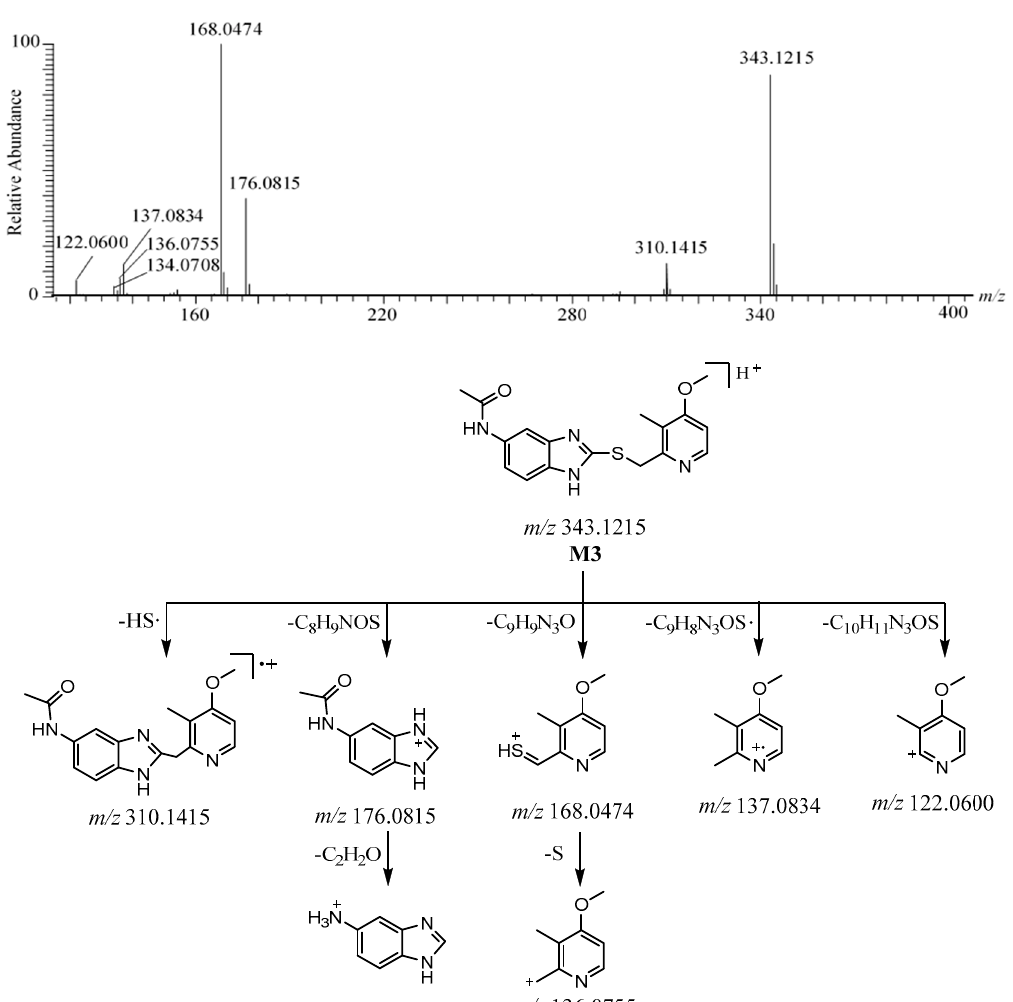
Figure 6. The HRMS/MS spectrum and the possible fragmentation pathway of